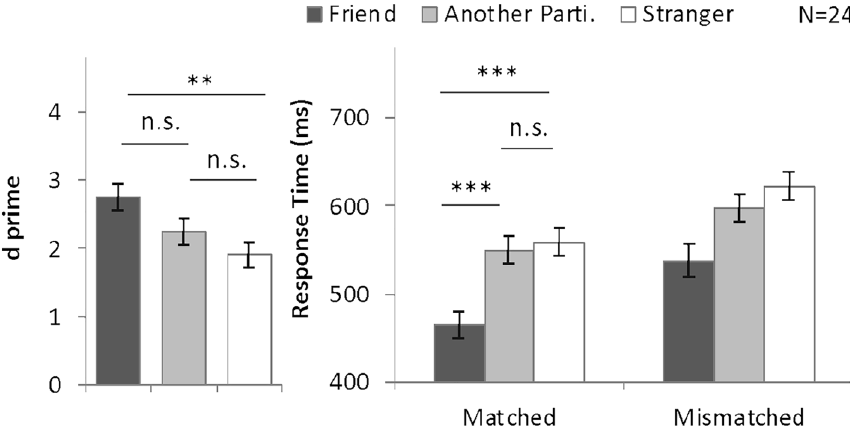
Figure 5. Mean and SE of d ′ and RT for different shape categories in Experiment 3. * P < 0.05, ** P < 0.01, *** P <